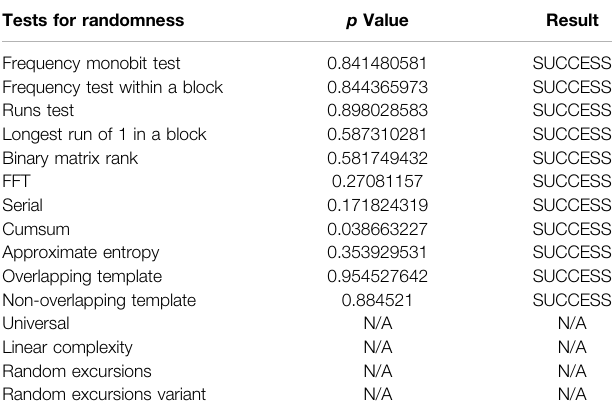
TABLE 3 | Results and p values are shown for various tests of randomness provided in the NIST suite. In all the cases, the p -values are greater than 0.01 and result in successful randomness distributions at 99% con fi dence level. The statistical tests are performed with 40,000 bit long random numbers, N/A corresponds tothosetestsrenderednonapplicableduetotherequirement of extremely long bit string length > 10 6 as mentioned in Ref.